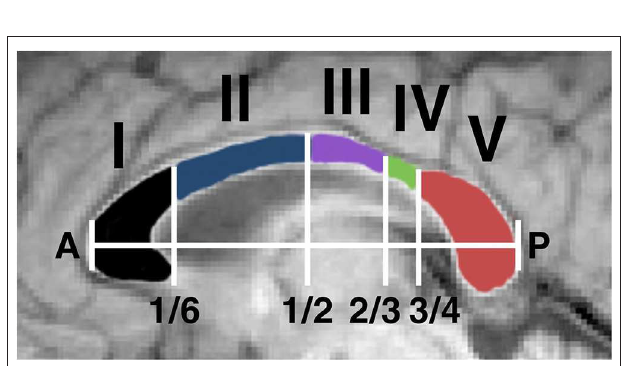
FIGURE 2 | The corpus callosum was segmented into structurally distinct regions for analysis of regional myelin water fraction. This was performed by an automated system which identified a maximum length anterior-posterior (AP) line and selected segments based on fractional AP position. The segments have been shown to contain fibres connecting (I) prefrontal, (II) premotor and supplementary motor, (III) motor, (IV) sensory, and (V) parietal, temporal, and occipital regions